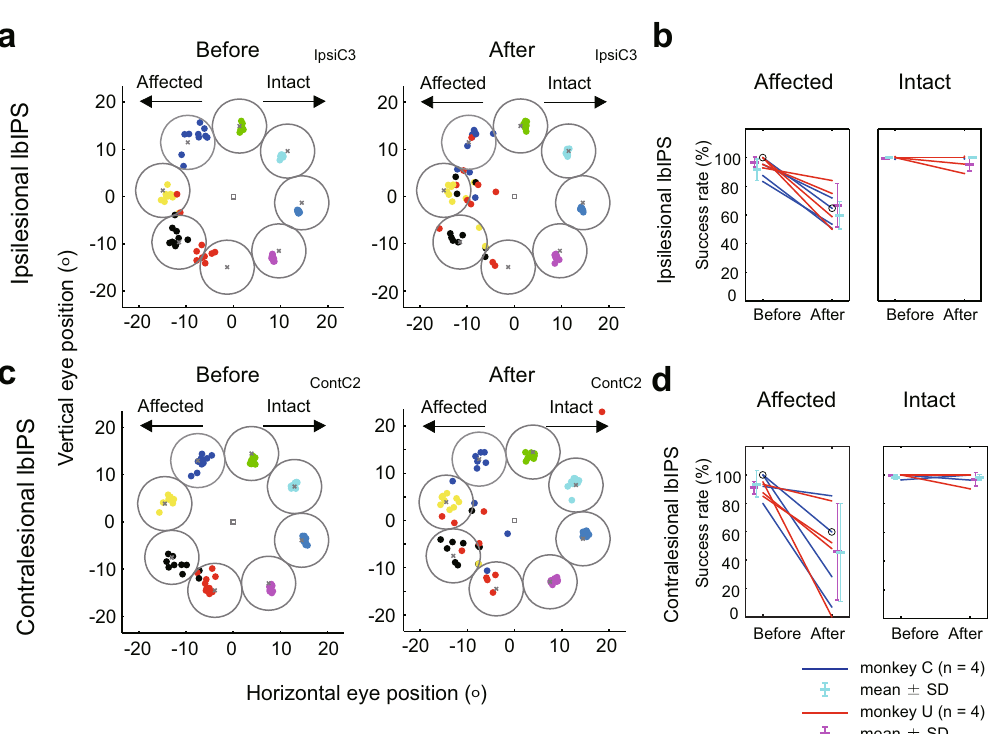
Fig. 6 Effects of reversible inactivation of the lbIPS in the step saccade task. a , c Each dot represents saccade endpoints and is color coded by target location. a Before (left) and after (right) inactivation of the ipsilesional lbIPS. b Before (left) and after (right) inactivation of the contralesional lbIPS. Target windows for successful saccades are indicated as circles. b , d Success rates of visually guided saccades to the target in the affected (left) and intact (right) visual fi eld. Inactivation of the ipsilesional ( b ) and contralesional ( d ) lbIPS. The data of target locations with the smallest (success rate [after] − success rate [before]) values by inactivation are plotted in b and d . The data for saccades toward the affected and intact visual hemi fi eld are represented in the left and right panel, respectively. The data points of individual experiments, before injection (before) and after injection (after), are presented on the left and right side of each panel with connecting lines, respectively. Experimental sessions in a and c are marked by open circles in b and d . For session IDs (IpsiC3 and ContC2), see Supplementary Table 1. The mean and SD of success rates in each monkey are plotted in cyan (monkey C) and magenta (magenta: monkey U). The target window (gray circle) was a circle with a radius of half the distance between target locations (radius = eccentricity × sin[45/2]). Thus, these windows did not overlap with each